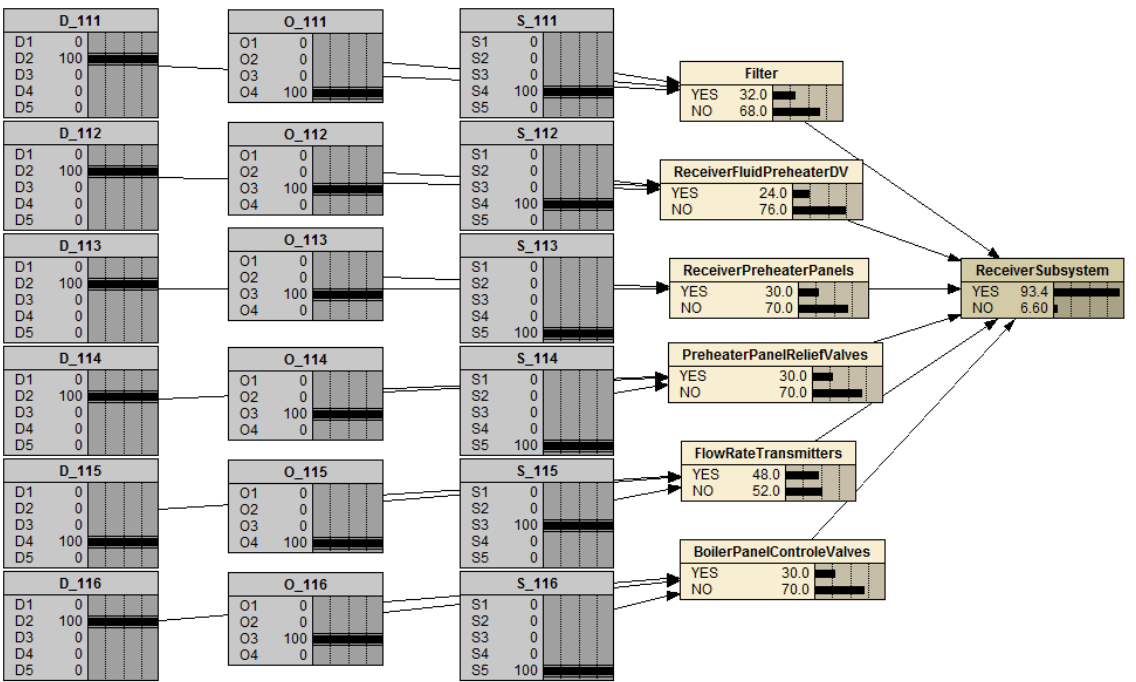
Figure 5. Determination of the prior and posterior criticality of receiver subsystem using NETICA software.